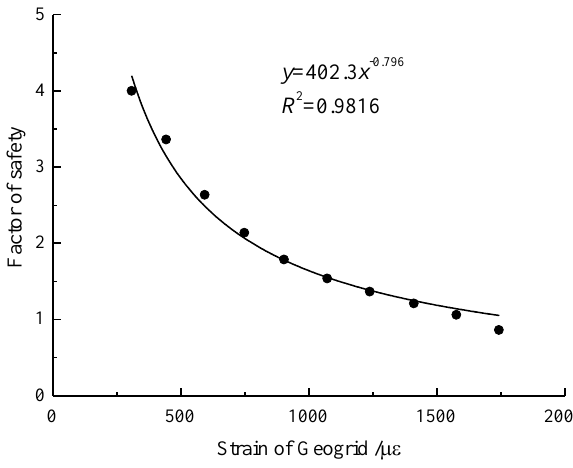
Figure 9. Relationships between the factor of safety and geogrid characteristic strain.